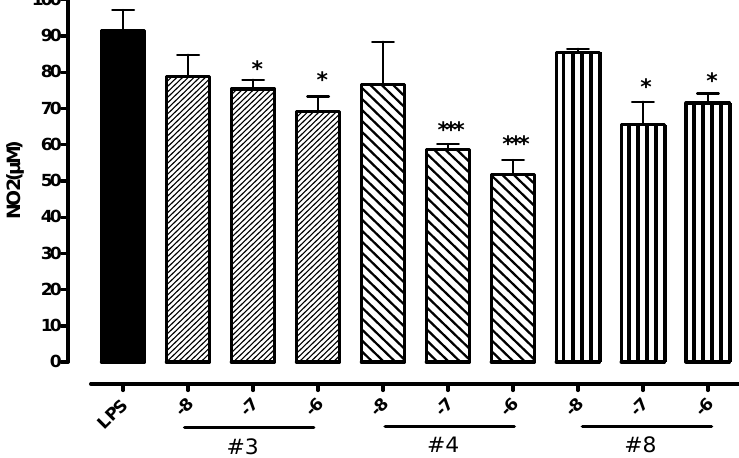
Figure 2. Effect of compounds 3 , 4 and 8 to LPS-stimulated macrophages J774.A1 on NO